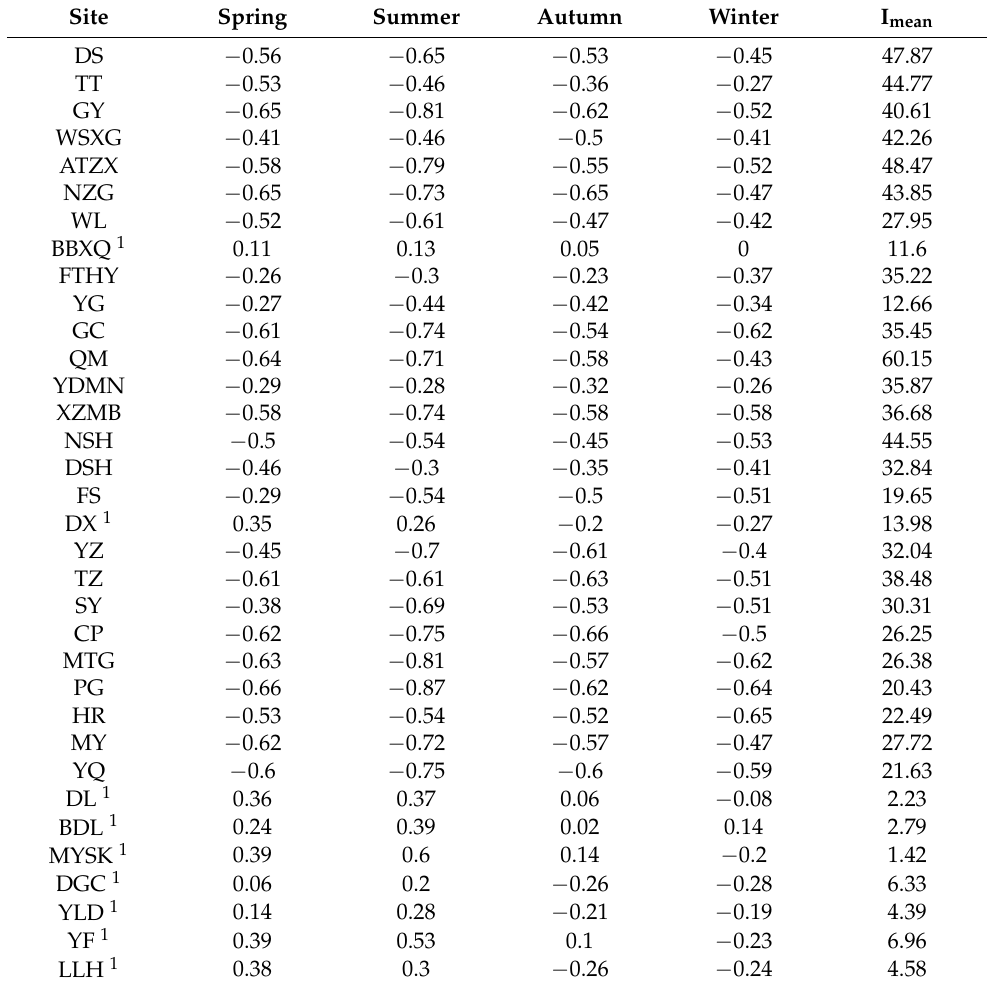
Table 3. Correlation coefficients between PM 2.5 / µ and ln(I) for each season at each site: I mean is the annual mean of radiance at each site in units of nW/cm 2 ·